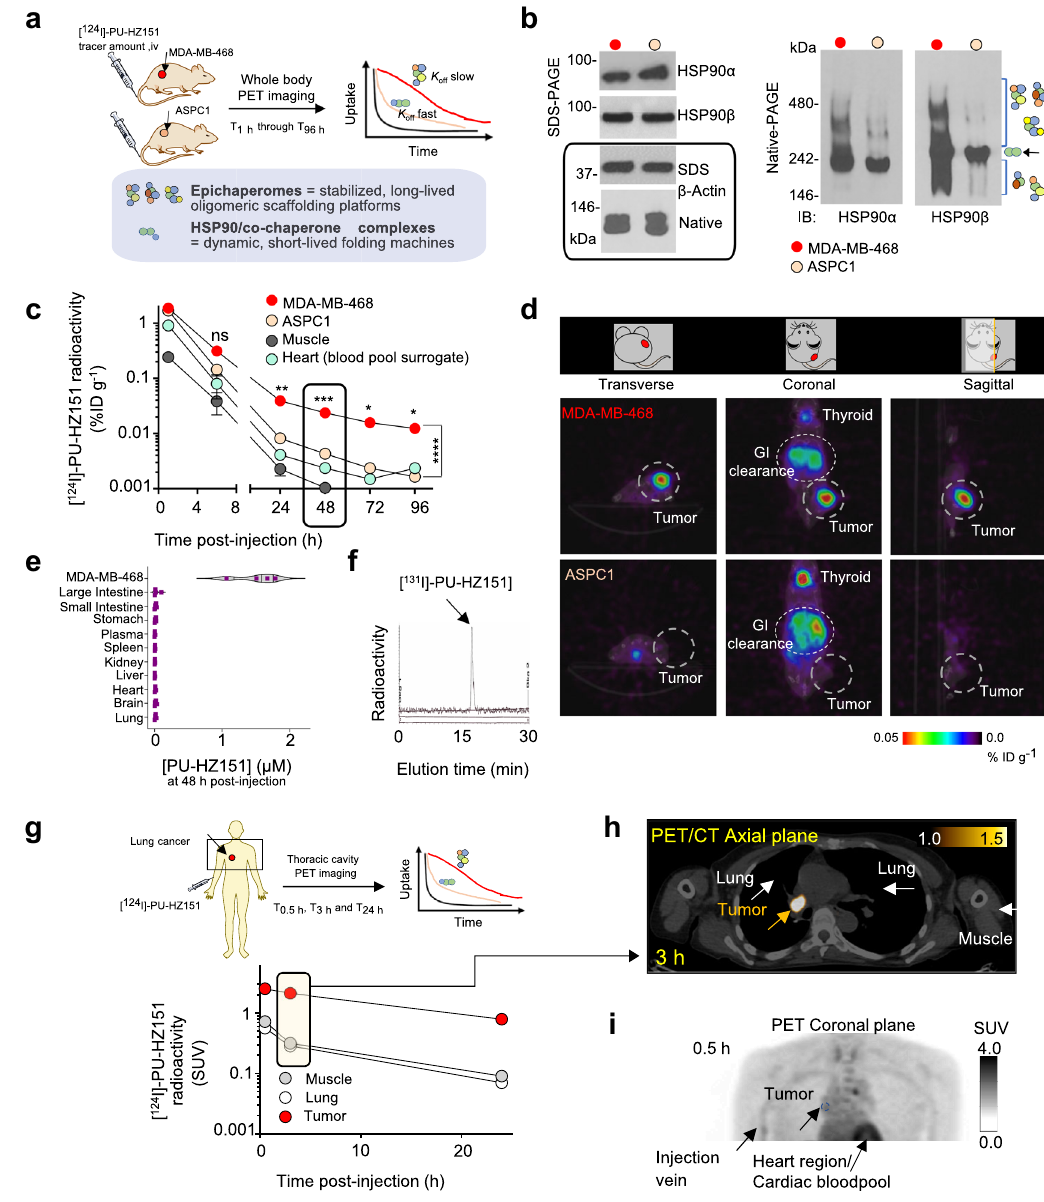
Fig. 3 PU-HZ151 kinetically selects for the epichaperome over HSP90. a Design of a surrogate method to determine epichaperome selectivity in vivo. iv, intravenous. b Native gels indicate epichaperome enrichment in MDA-MB-468 despite comparable total levels of HSP90 in both MDA-MB-468 and ASPC1 cells (as shown by denaturing gels). Epichaperomes appear as multiple high-molecular weight complexes in Native PAGE (see brackets). Conversely, HSP90 complexes, highly dynamic, and short lived, are detected as a band, putatively a homodimer (see arrow). β -Actin, loading control. c PET determined time-dependent concentration of [ 124 I]-PU-HZ151 in xenografted epichaperome + ve (MDA-MB-468) and – ve (ASPC1) tumors. Muscle and heart are shown for comparison. Serial PET images were obtained at the times indicated after single intravenous infusion of a microdose of [ 124 I]-PU- HZ151. Data are presented as mean ± s.e.m., two-way ANOVA with Sidak ’ s post-hoc, n = 5 mice per tumor type. 24 h, p < 0.0048, 48 h, p < 0.0002, 72 h, p < 0.0173, 96 h, p < 0.0120; F (1.009, 8.075) = 98.30. d PET image of representative mice as in c obtained at 48 h post single [ 124 I]-PU-HZ151 injection (250 µ Ci; 12.5 µ Ci g − 1 ). e LC/MS-MS determined molar concentration of PU-HZ151 in the indicated tissues and organs at 48 h after single-dose intraperitoneal (i.p.) administration of 75 mg kg − 1 PU-HZ151. Graph, violin plot shows the distribution of individual mice with center line, median; box limits, upper and lower quartiles; whiskers, 1.5× interquartile range of n = 4. f Radio-HPLC of tumor extracts shows intact PU-HZ151 in MDA-MB-468 tumors (representative of n = 4) at 24 h post-single iv injection of 1 mCi [ 131 I]-PU-HZ151. See also Supplementary Fig. 16. g PET determined time-dependent concentration of [ 124 I]-PU-HZ15 (10 mCi) in a lung cancer patient. Serial PET images were obtained at the times indicated after single intravenous infusion of a microdose of [ 124 I]-PU-HZ151. h Representative axial PET/CT image obtained at 3 h as in g . i A 3-D maximum intensity projection (MIP) PET image of the chest, obtained at 0.5 h after iv injection of [ 124 I]-PU-HZ151 as in g , is shown to demonstrate the homogeneous distribution of the probe into tumor and surrounding tissues. Tumor ’ s relative circumference is shown with a blue circle. Source data are provided as a Source Data fi le.